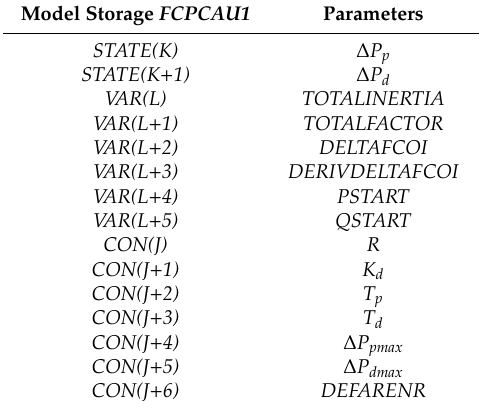
Table 2. FCPCAU1 Model Storage Parameters.